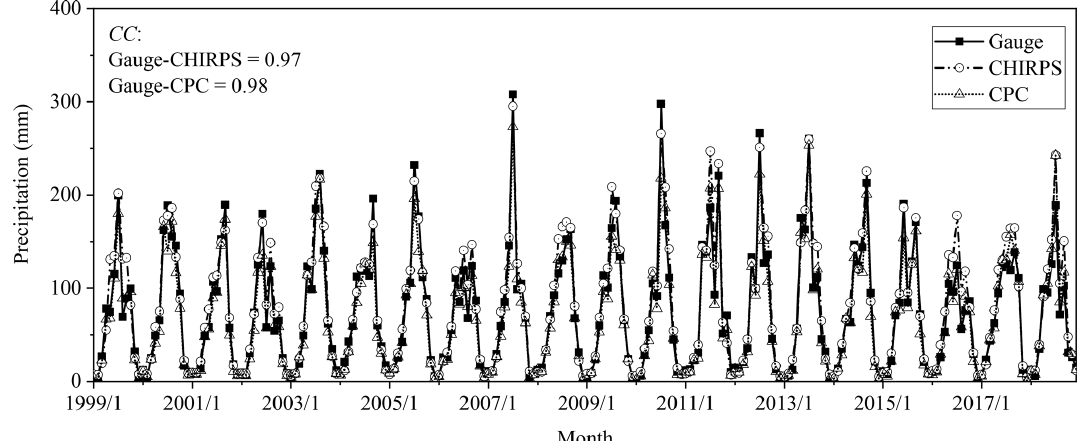
Figure 3. Time series of three different precipitation records at a monthly scale in the JRW (the CC values of 0.97 and 0.98 indicate an extremely significant positive correlation; p< 0 . 01, where p stands for the probability of being rejected when there was a significant difference). Please note that the date in this figure is given as year/month.